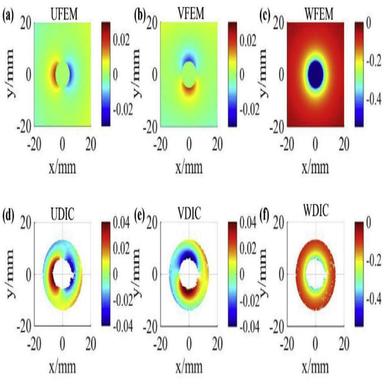
Displacement field, (a),(b) and (c) calculated by FEM; (d),(e) and (f) measured by 3D-DIC.